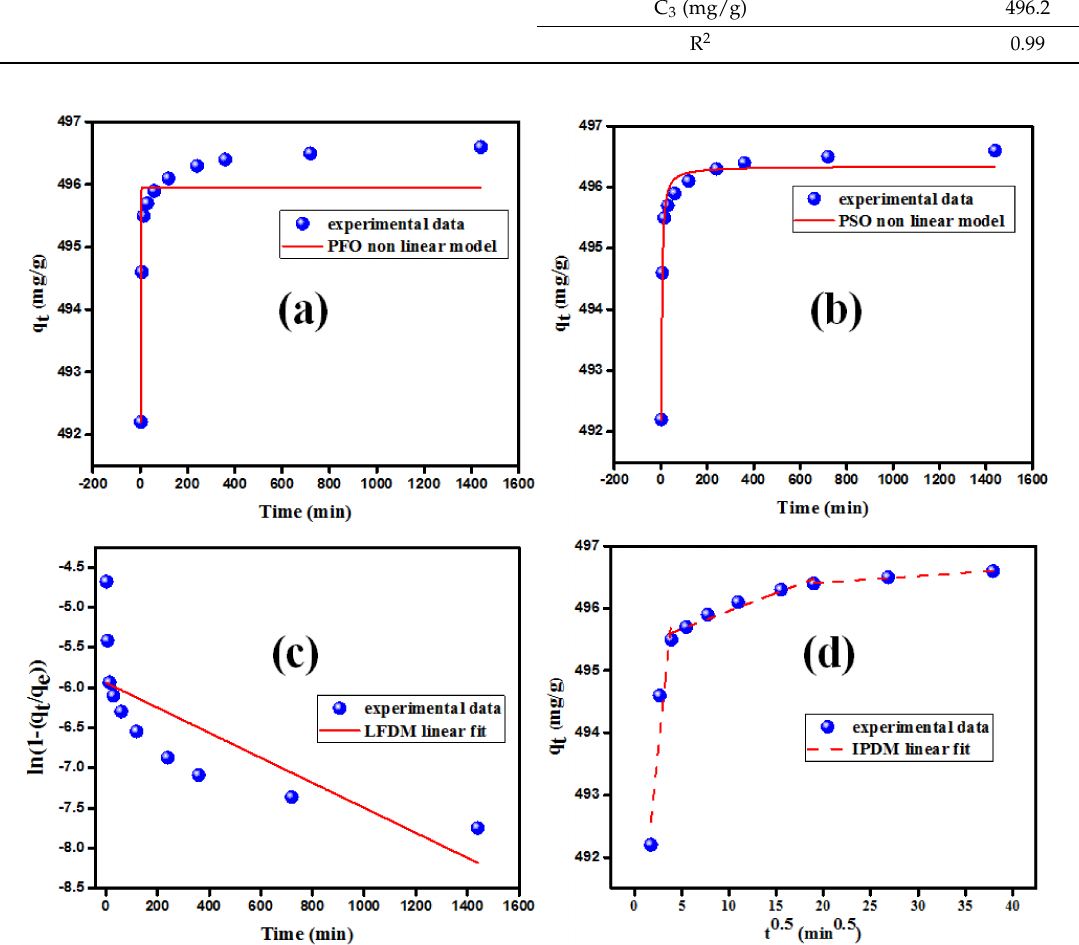
Figure 5. ( a , b ) Nonlinear pseudo-first-order and pseudo-second-order kinetic plots; ( c , d ) the liquid film diffusion model and intraparticle diffusion model